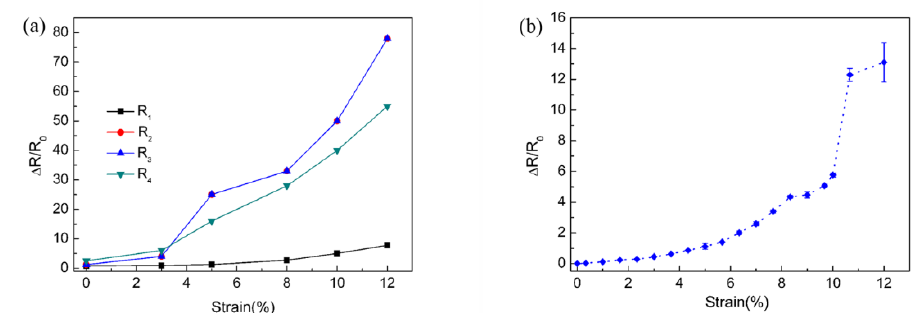
Figure 6. ( a ) The change of resistance under strain. ( b ) The relative direct-current (DC) resistance change under strain.